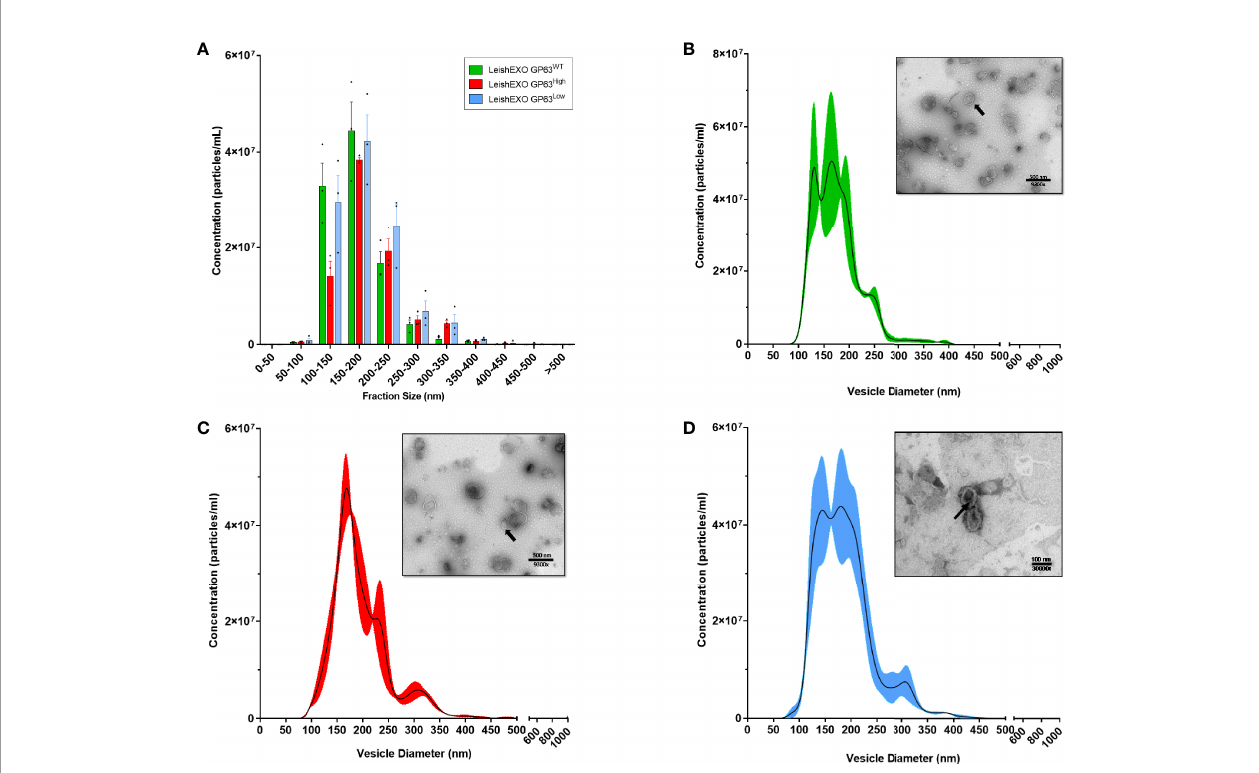
FIGURE 1 | The 3 different populations of Leishmania amazonensis-derived EVs showed similar morphologic characteristics when analyzed by Transmission Electronic Microscopy (TEM) and Nanoparticles Tracking Analysis (NTA). (A) Grouped distribution of diameter size of various Leishmania amazonensis -derived EVs by NTA; (B – D) Curve lines of the diameter size distribution of Leishmania amazonensis GP63 WT , GP63 High, and GP63 Low -derived EVs with their correspondent TEM image respectively. Magni fi cation = 9500x or 30000x; Bar = 500nm or 100nm; Arrows = Single